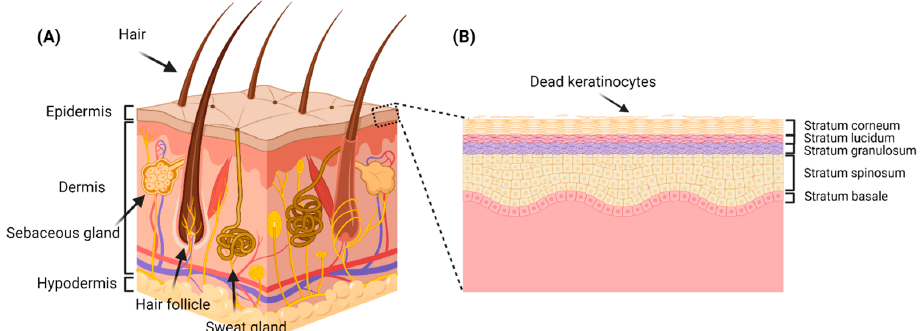
Figure 1. ( A ) Skin structure showing the three distinct layers of epidermis, dermis, and hypodermis, and skin appendages including hair follicle and shaft, sebaceous gland, sweat gland, and arrector pili muscle; and ( B ) epidermis structure showing the five distinct layers of stratum corneum, stratum lucidum, stratum granulosum, stratum spinosum, and stratum basale. Created with BioRender.com (accessed on 4 February 2023).